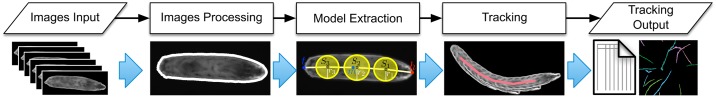
Flow chart of the tracking module.